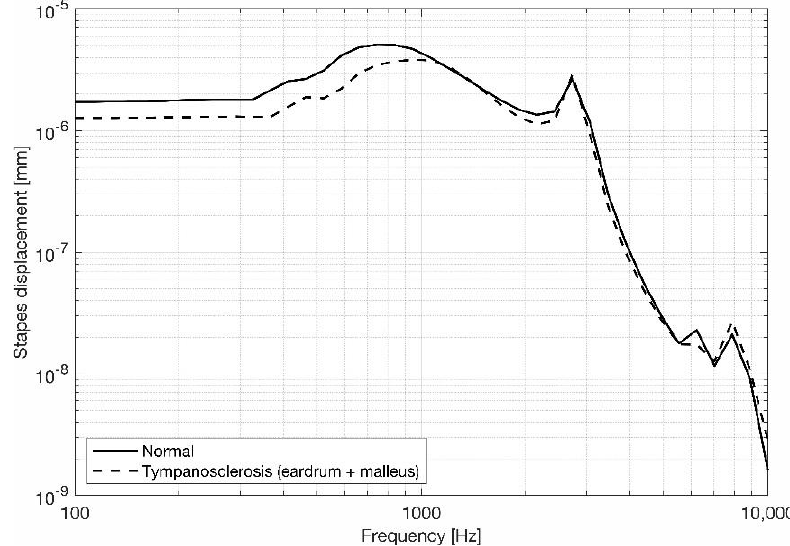
Figure 9. Stapes footplate displacements ’ magnitude, comparing the model that was representative of a normal ear and tympanosclerosis affecting the eardrum and the malleus.